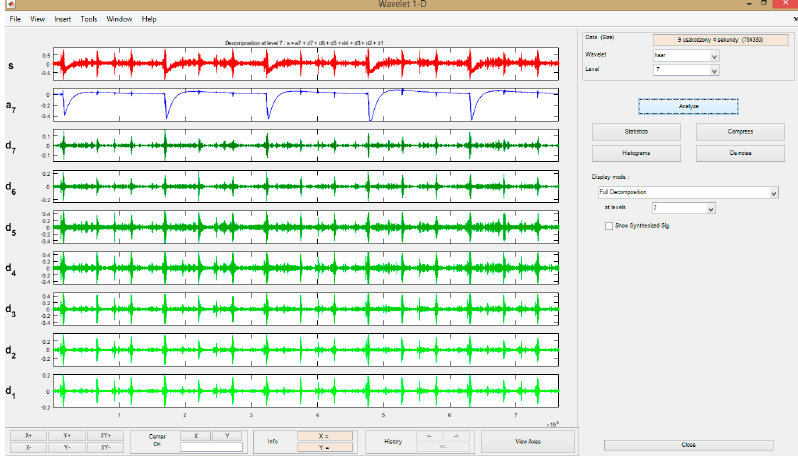
Figure 15. The wavelet decomposition using the Haar function for early detected fault of the valve unit.